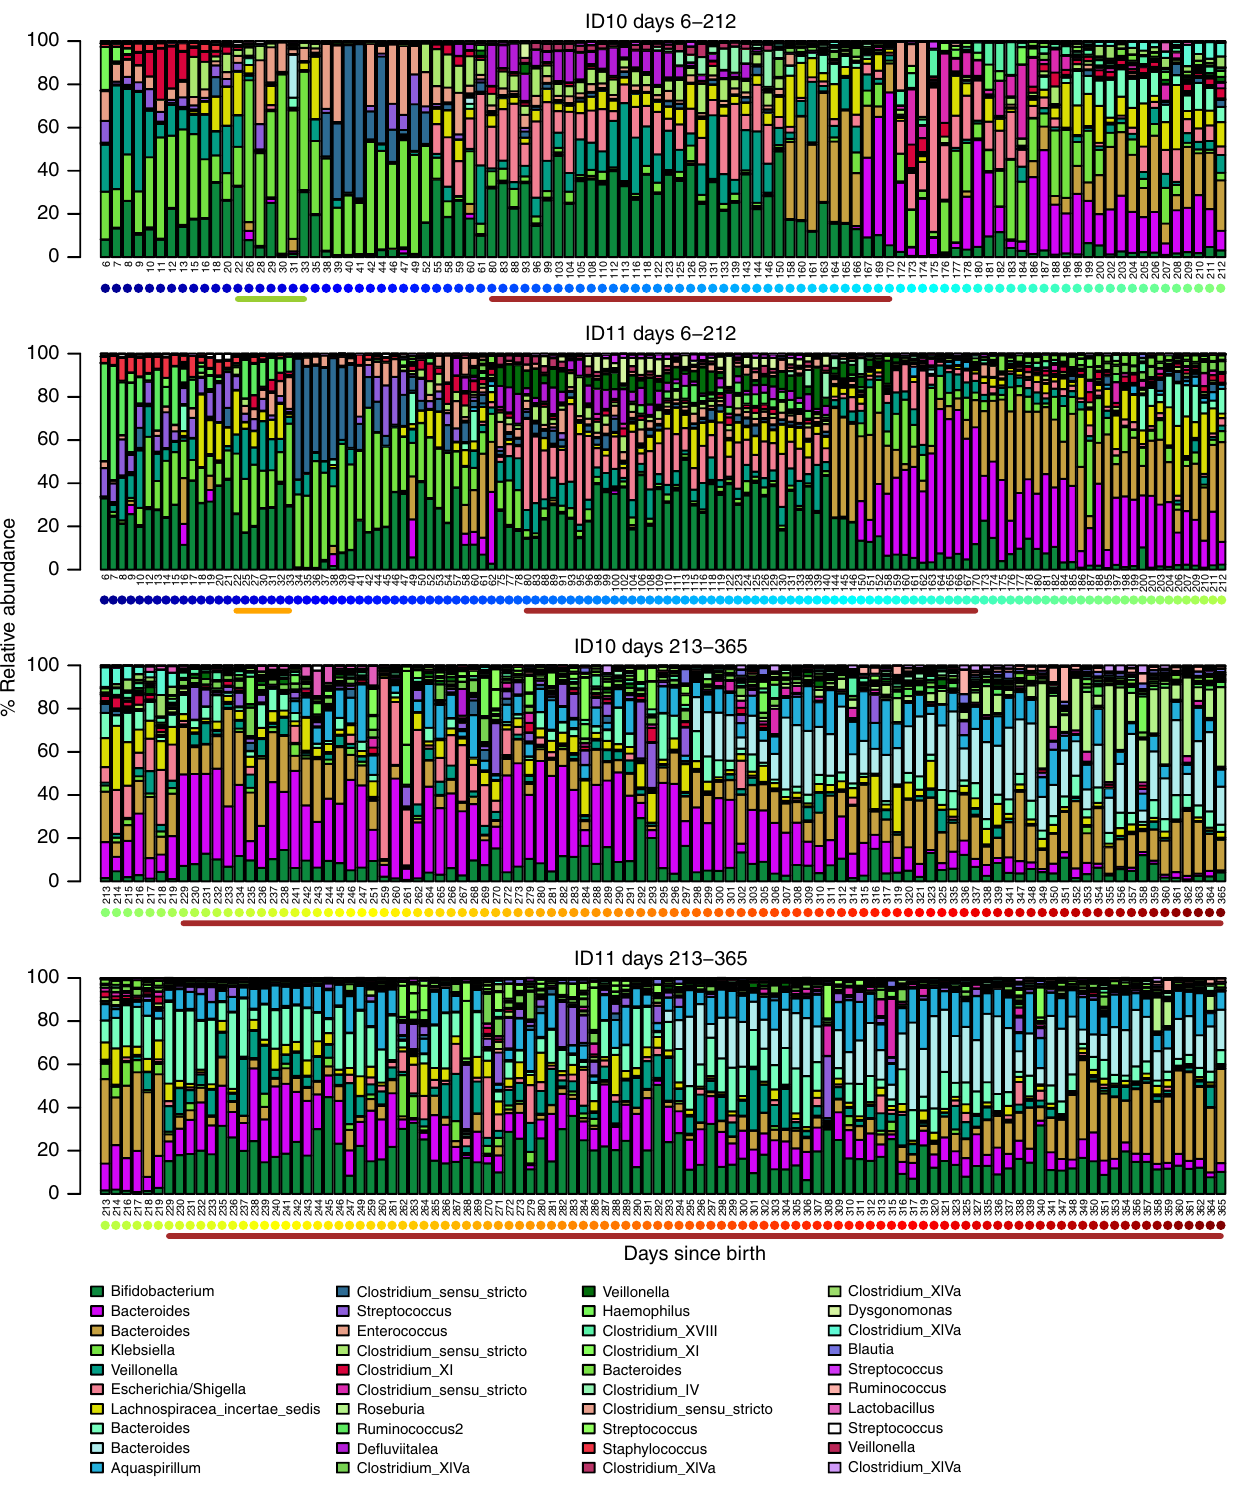
Fig. 4 Two fraternal twins track each other closely over the fi rst year of life, in spite of one receiving intensive antibiotic treatment. Each panel shows relative abundances of the 40 most abundant genera in ID10 and ID11, with each bar representing a sample and each colored bar segment representing the relative abundance of the genus indicated in the colour key below. The green line beneath the top panel indicates the period during which ID10 received antibiotic treatment. The corresponding period for ID11 is indicated by the orange line beneath the second panel. The brown horizontal lines indicate time spent outside Norway. Dots beneath the days since birth ( x -axes) indicate the time of sampling (dark blue to dark red = early to